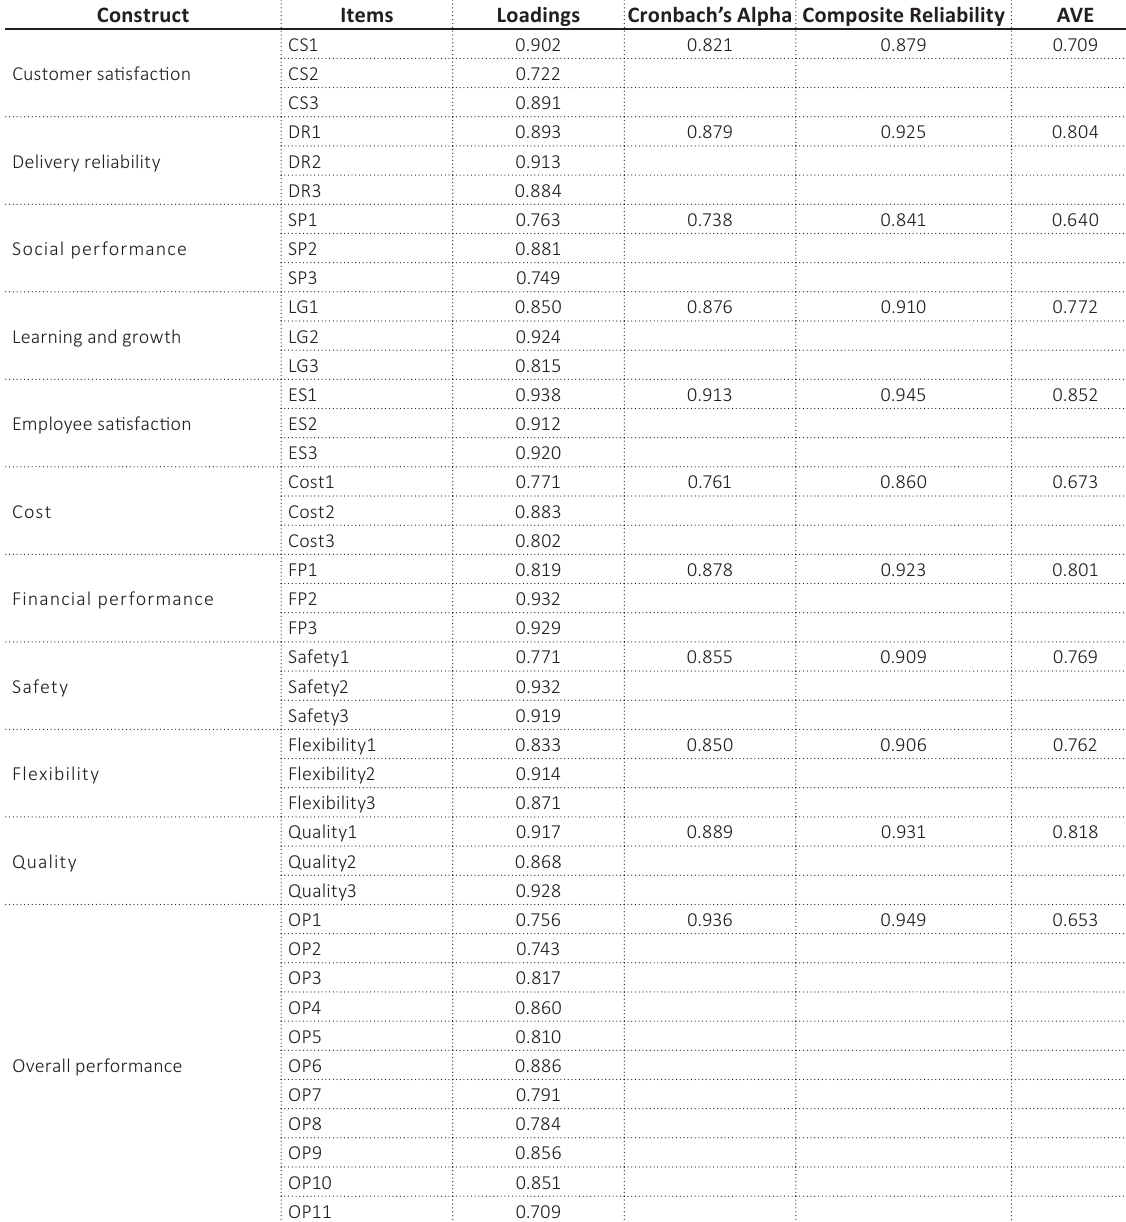
Table 3. Internal consistency reliability and convergent validity